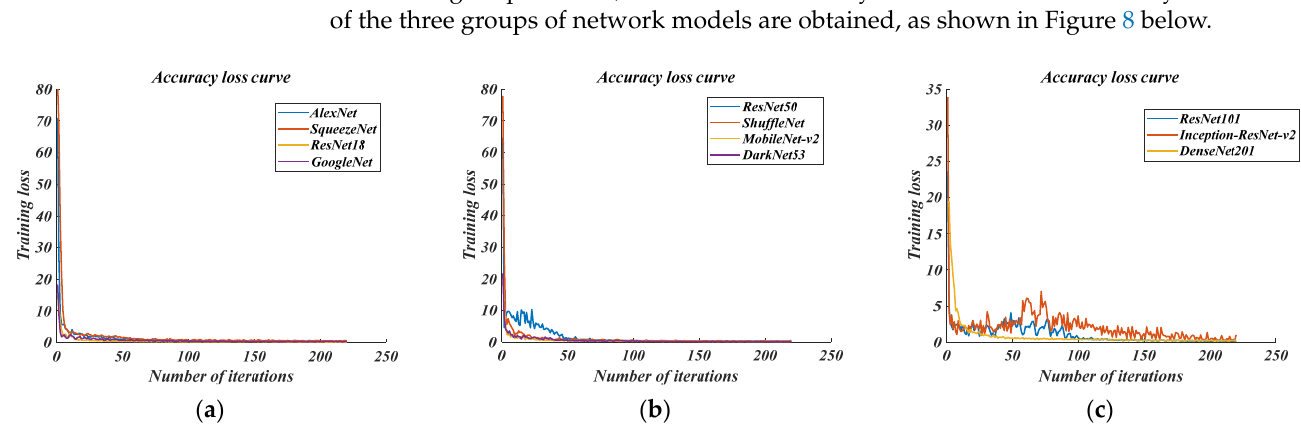
Figure 8. Accuracy–loss curve in this research. ( a ) Lightweight network; ( b ) Robust network; ( c ) Complex network.